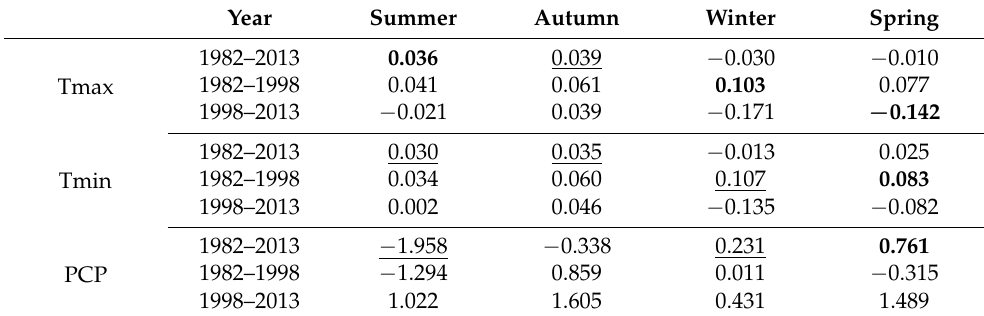
Table 2. Trend of climate factors in